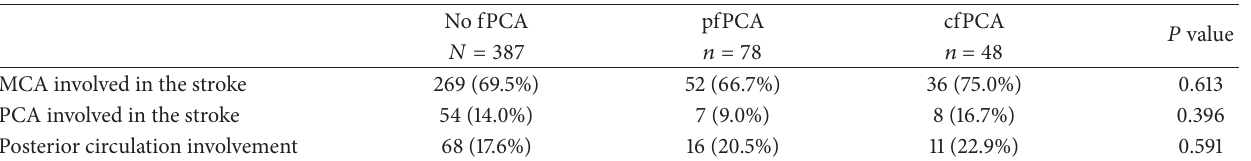
Table 3: Vascular involvement of the stroke in patients without fetal PCA (no fPCA), partial fetal PCA (pfPCA), and complete fetal PCA